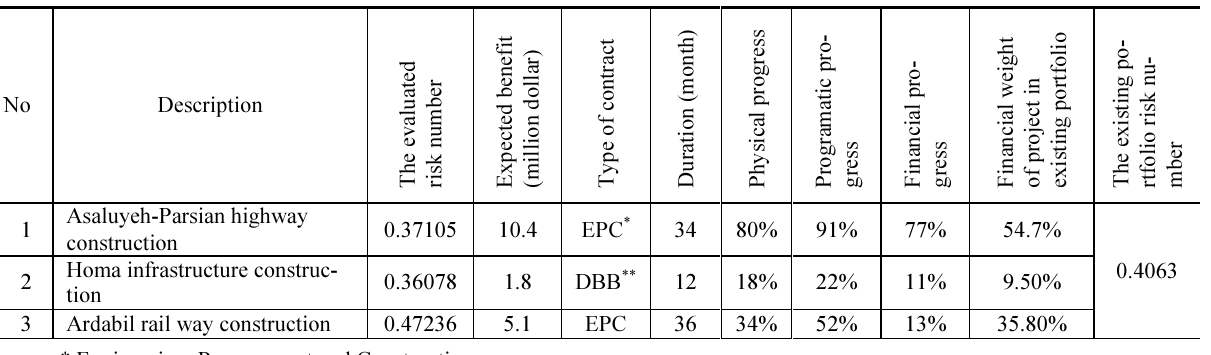
Table 4. Evaluation of existing project